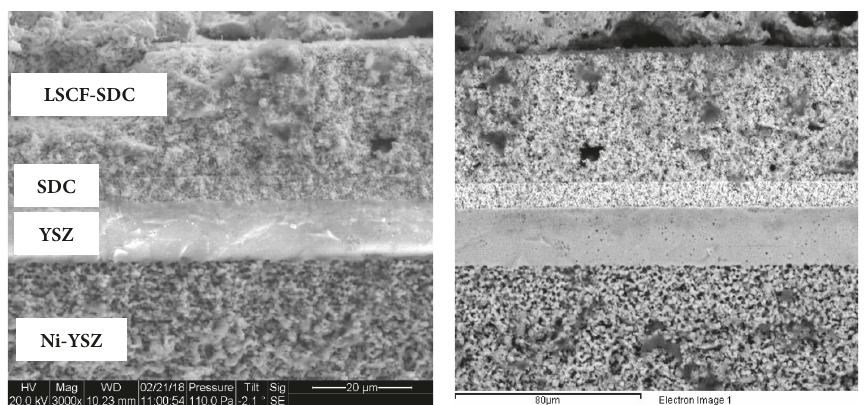
Figure 2: SEM cross section images of the tested SOFC cell.